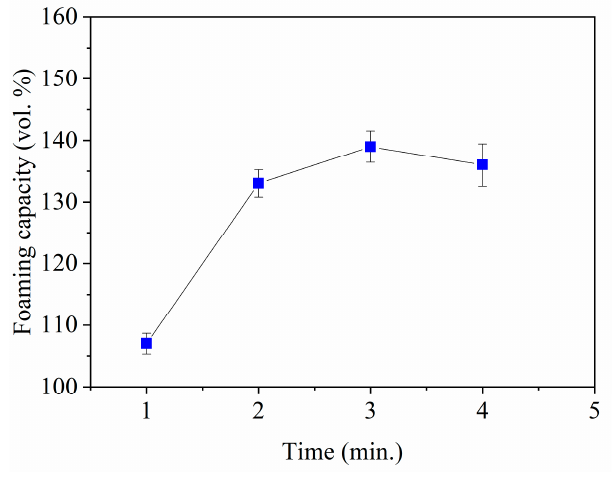
Figure 7. Foaming capacity as a function of stirring time for the slurries prepared with a load of 37 vol.% MgAl 2 O 4 and 3 wt.% SE for a stirring rate of 1070 rpm.